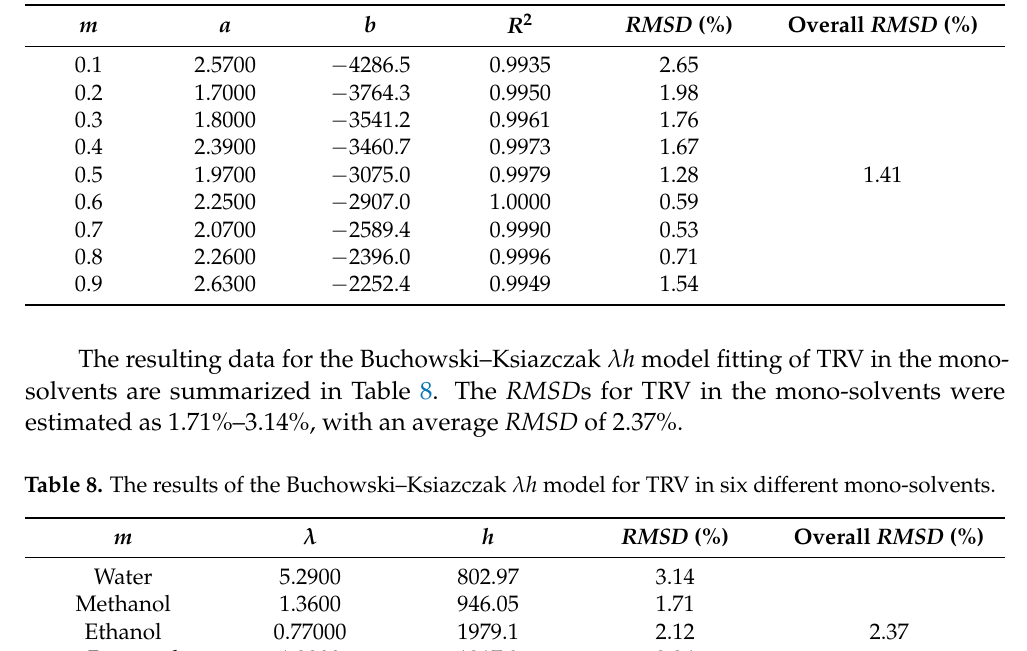
Table 7. The results of the van’t Hoff model for TRV in various PG + water compositions.